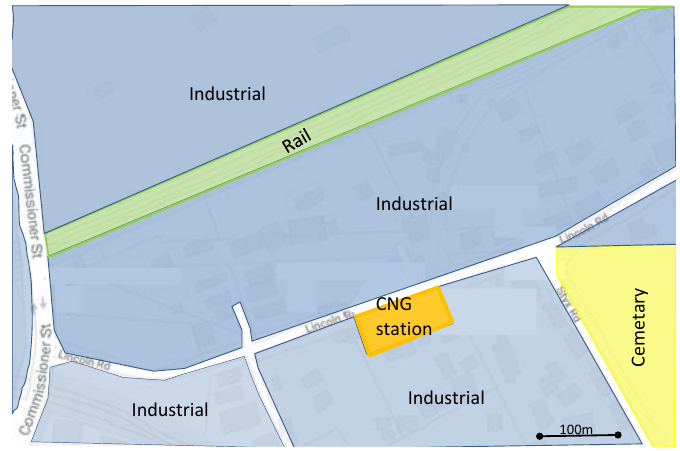
Figure 2. Station location and land use